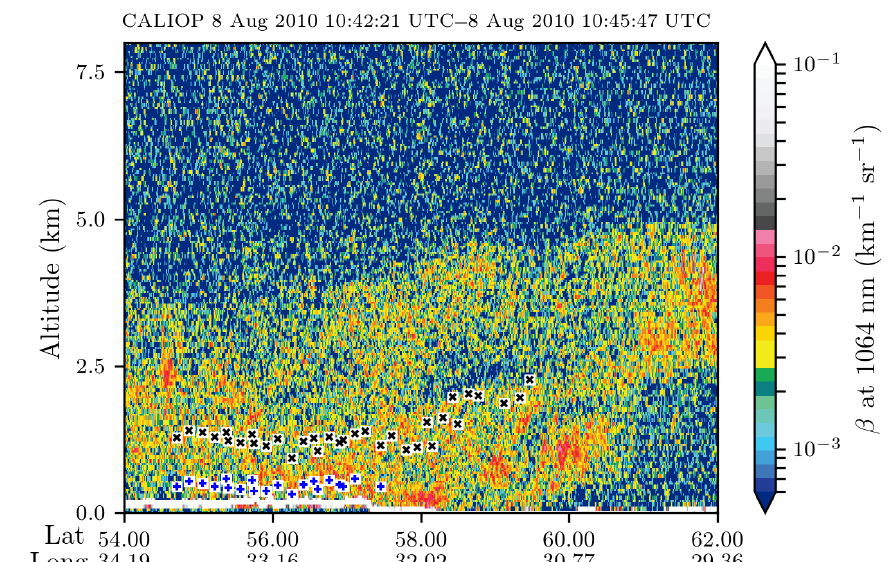
Figure 6. GOME-2A-derived aerosol layer heights co-located within 100km to the CALIPSO ground track (using great circle distance), plotted over attenuated backscatter ( β ) of the CALIOP lidar at 1064nm. The blue and black markers in white squares represent converged ALH from the formal approach and the dynamic scaling method,